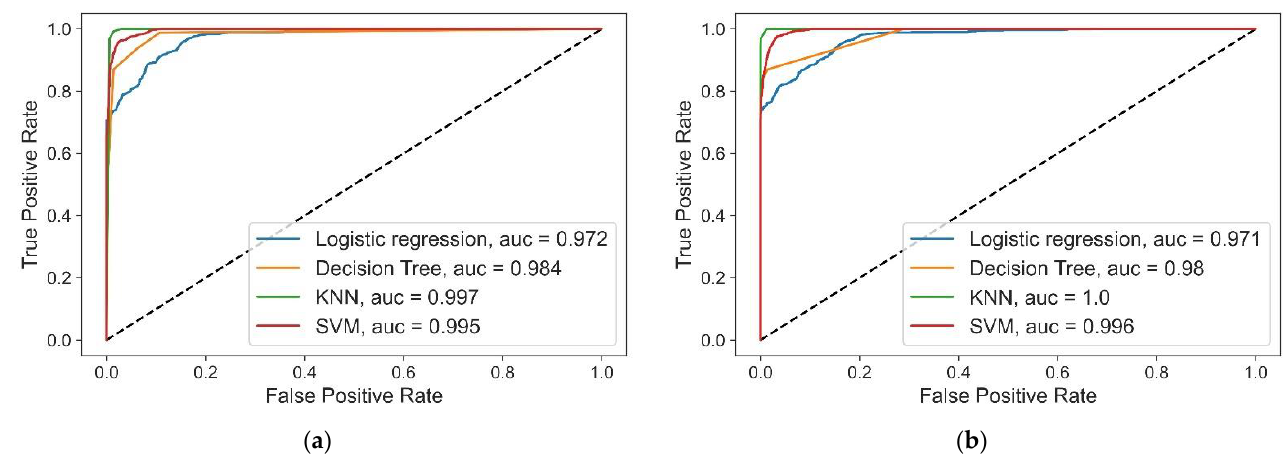
Figure 18. Area under the ROC curve (AUC) and receiver operating characteristics (ROC)—Results for Strategies ( a ) 1 and ( b ) 2.